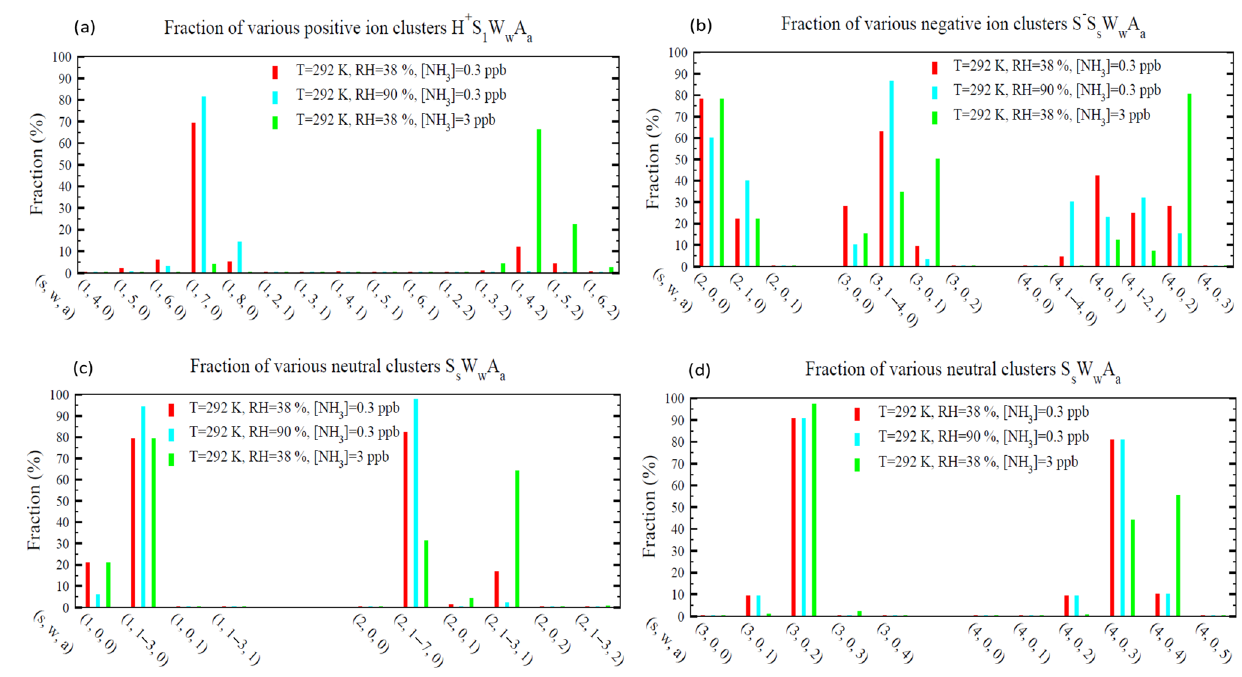
Figure 3. Relative abundance (or molar fraction) of small clusters containing a given number of H 2 SO 4 molecules for positive (a) , nega- tive (b) , and neutral (c, d) cluster types at a temperature of 292K and three different combinations of RHs (38% and 90%) and [NH 3 ] (0.3 and 3ppb). Some clusters with different numbers of water molecules were grouped together to make the plot more clear and neat. For the clusters shown in (d) , there are no hydrate data and thus hydration for these clusters was not